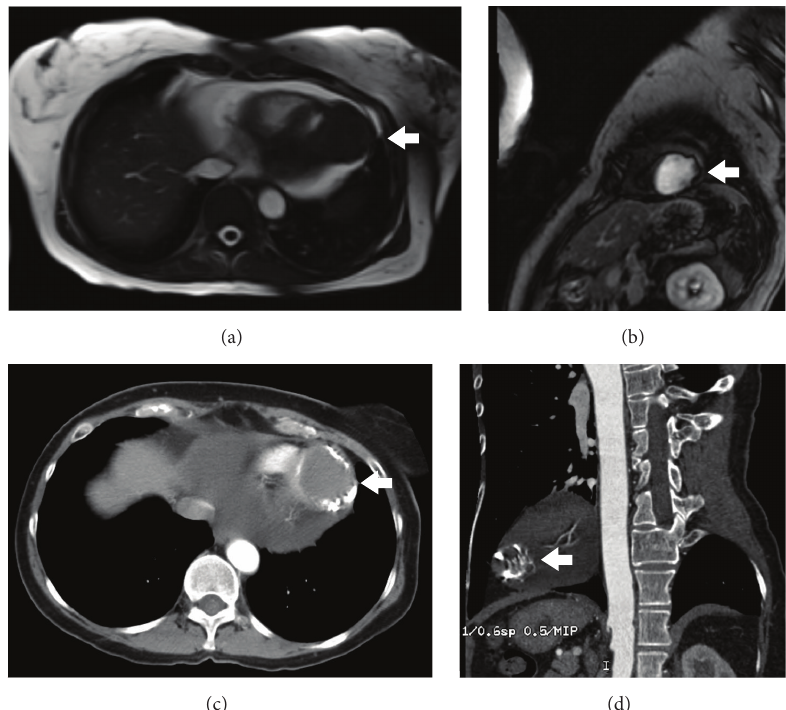
Figure 1: MRI imaging revealing the cardiac fibroma attached to the left ventricle (white arrow) surrounded by pericardial effusion (a and b). CT imaging revealing cardiac fibroma with peripheral calcifications (c and d).